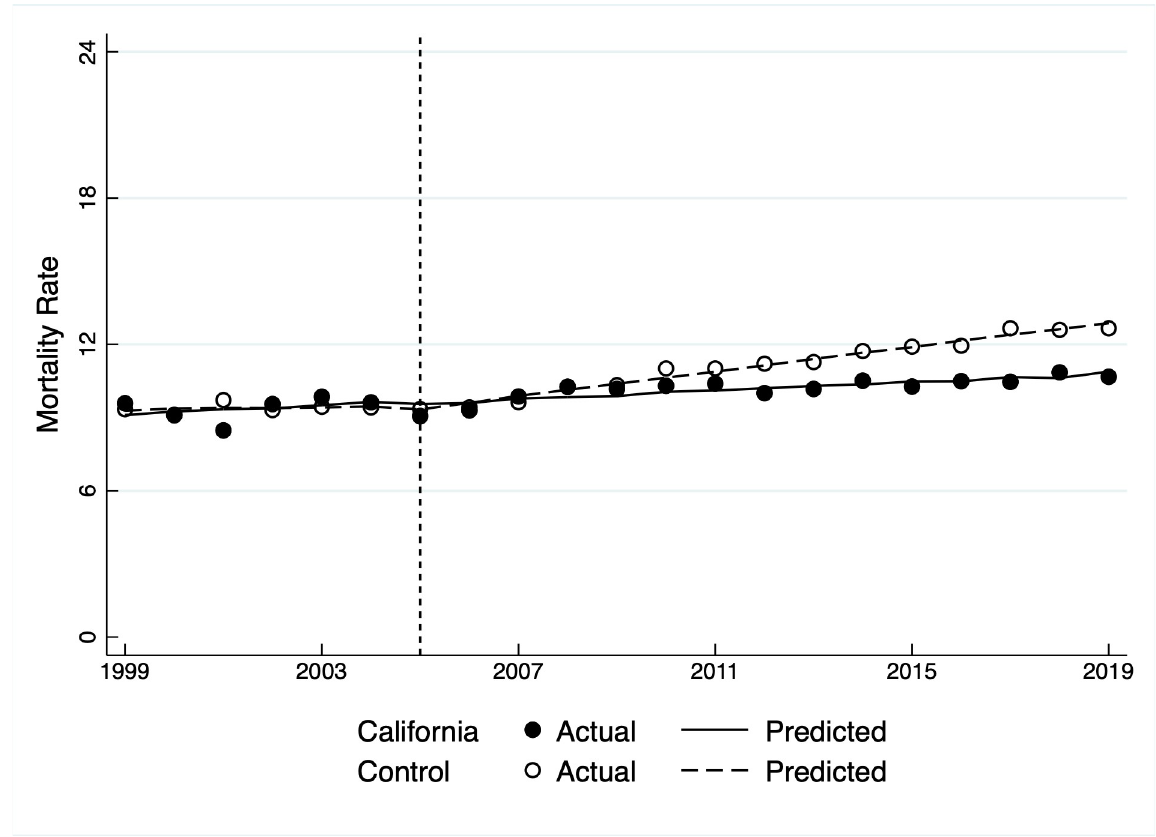
Fig 6. Actual and predicted suicide mortality rates for California’s general population,